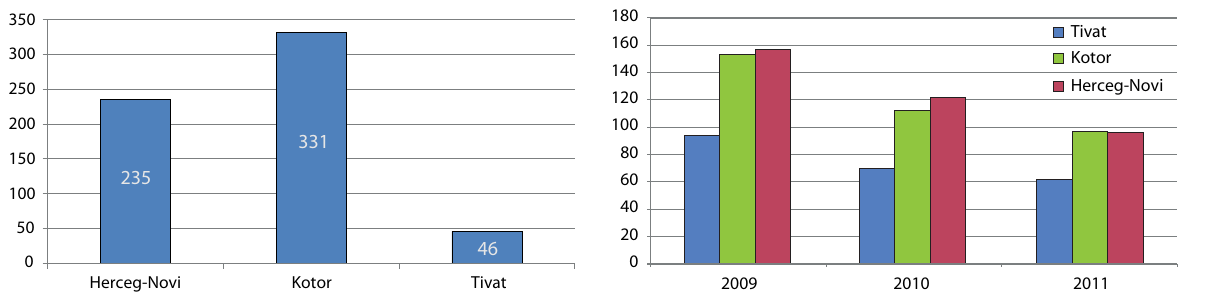
fig. 5. Comparison of Boka Bay borough sizes fig. 6. number of Approved Construction